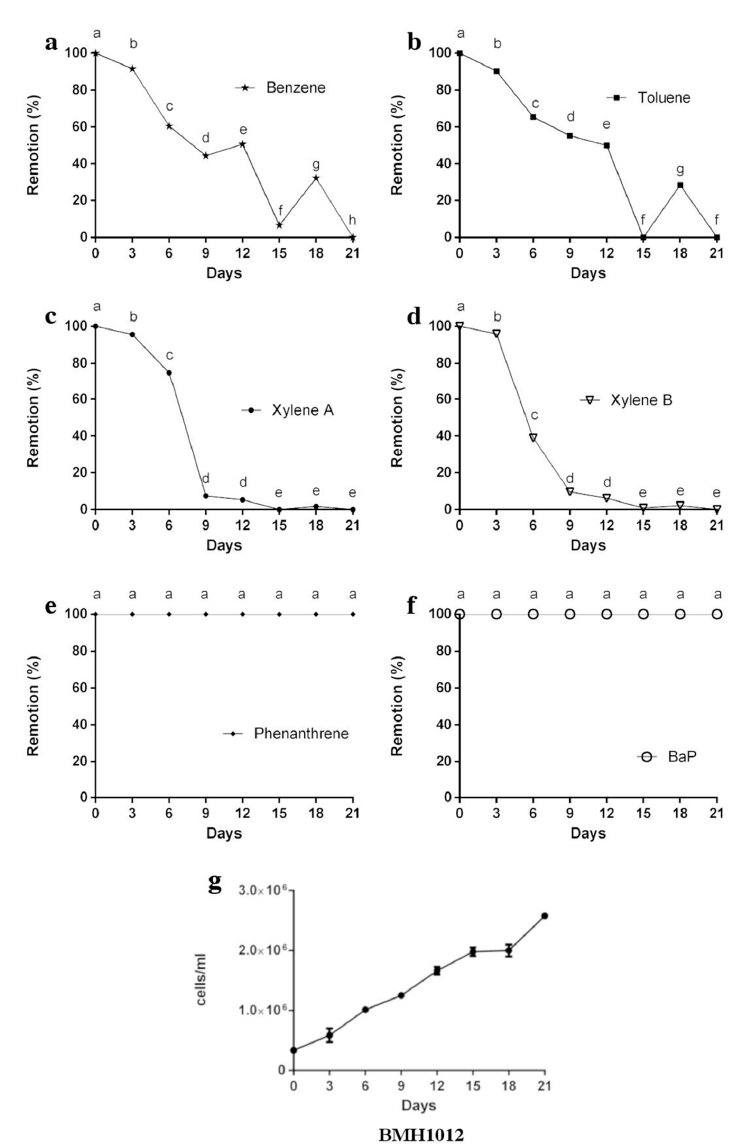
Figure 5. The remaining percentage of aromatic hydrocarbons removed by strain Rhodotorula BMH1012. ( a ) Benzene, ( b ) Toluene, ( c ) Xylene A, ( d ) Xylene B, ( e ) Phe, and ( f ) BaP removal after 21 days of fermentation. ( g ) Growth curve of Rhodotorula strain during fermentation with AH’s. Data is presented as the average amount of aromatic hydrocarbon remaining in the media (%) ± standard deviation (error bars). Letters indicate levels of significance and statistical di ff erences. ANOVA p -value <